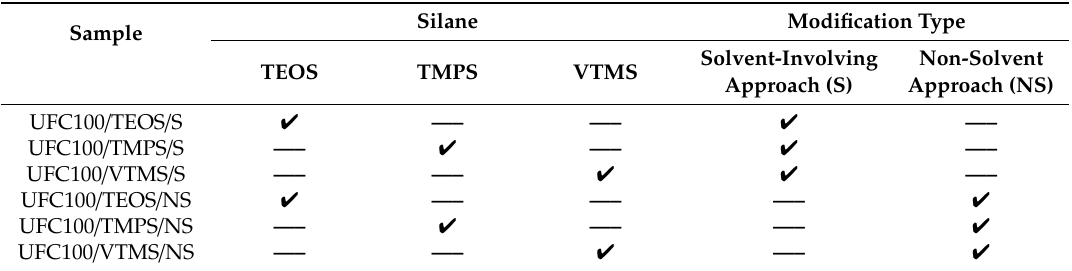
Table 1. Summary of performed cellulose modifications. Abbreviations: TEOS—triethoxyoctylsilane;